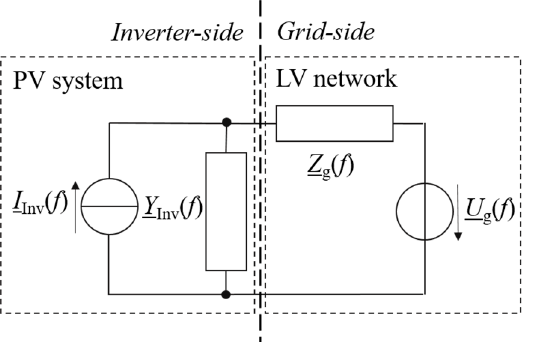
Figure 1. Impedance-based model of a photovoltaic (PV) system and the low voltage (LV) net- work.